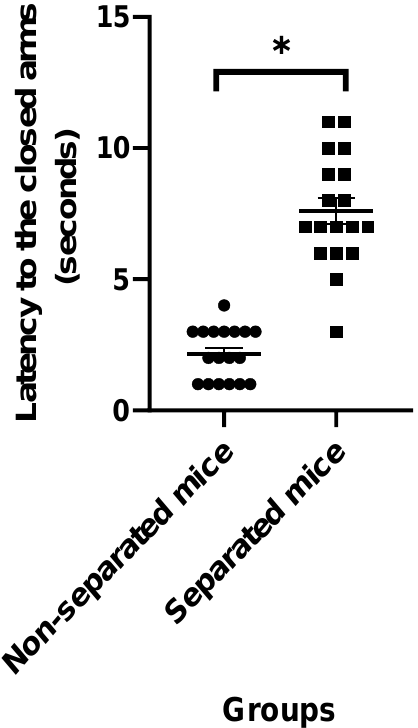
Figure 1. Latency to the closed arms. (*) indicates significant difference ( p < 0.05) between separated and non-separated mice by the unpaired t test ( n = 18/each group).